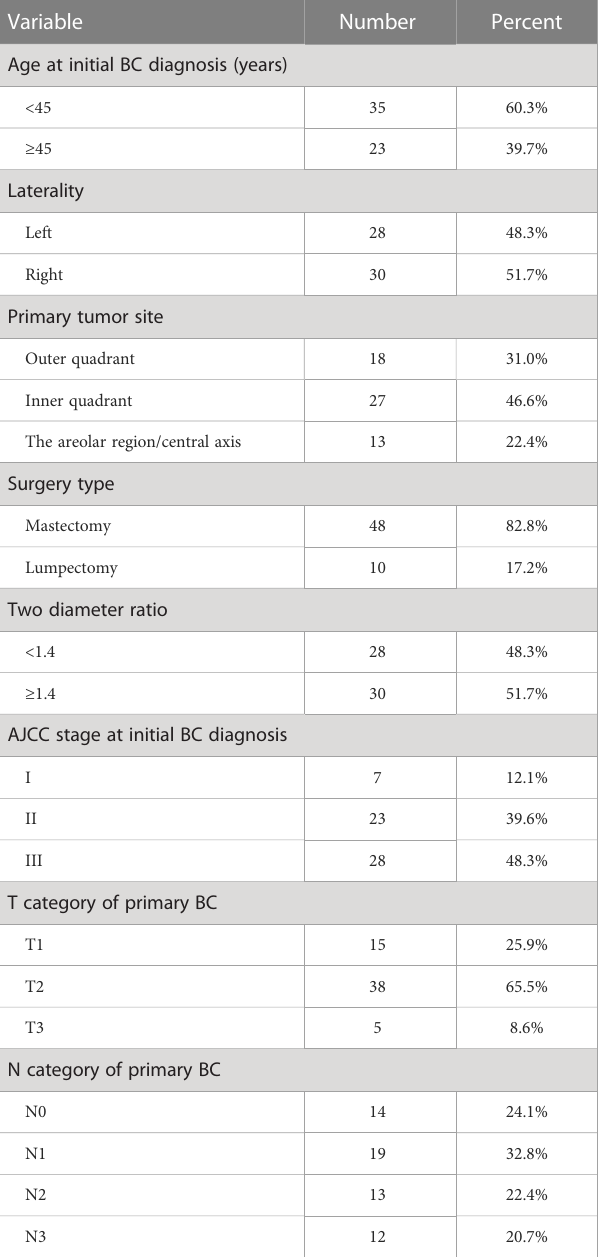
TABLE 2 Characteristics of patients with PM as the only site of distant metastasis at fi rst MBC